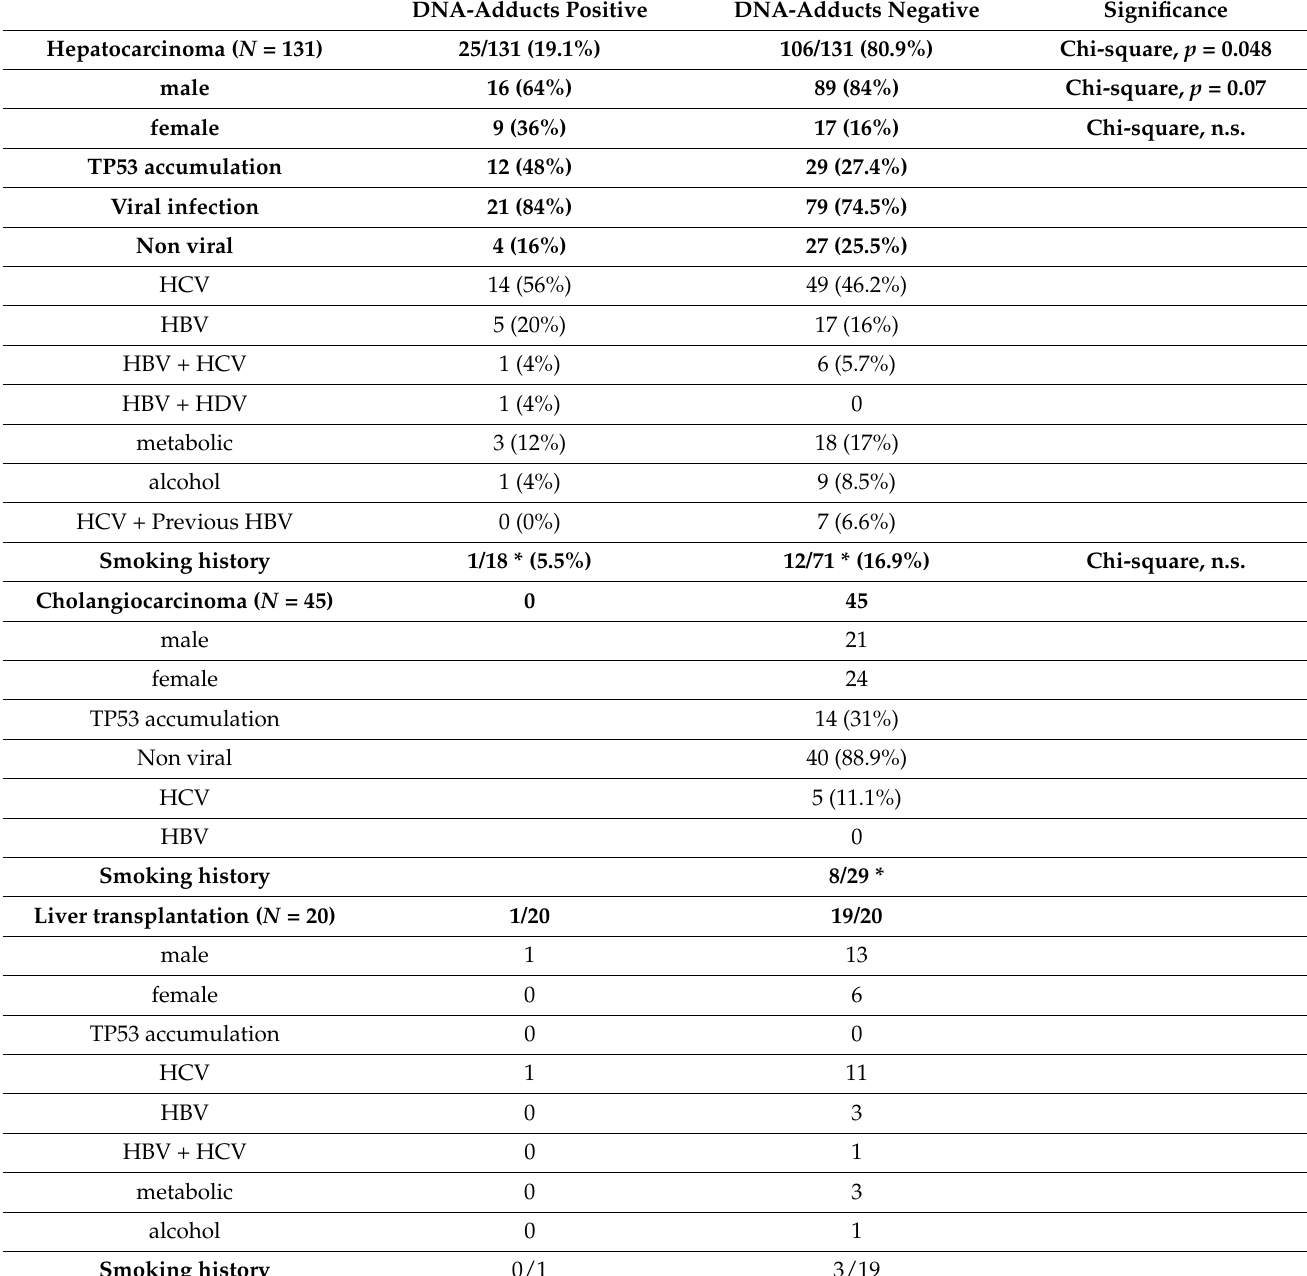
Table 1. Demographic, risk factors and molecular associations. DNA-Adducts